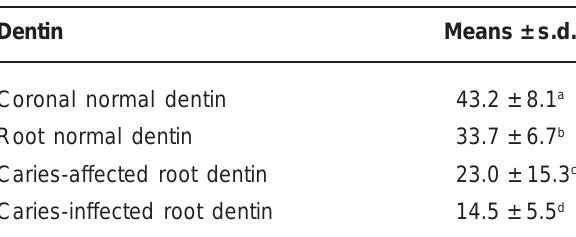
Distinct superscript letter indicate significantly different (ANOVA and Fisher’s PLSD, p <0.05)